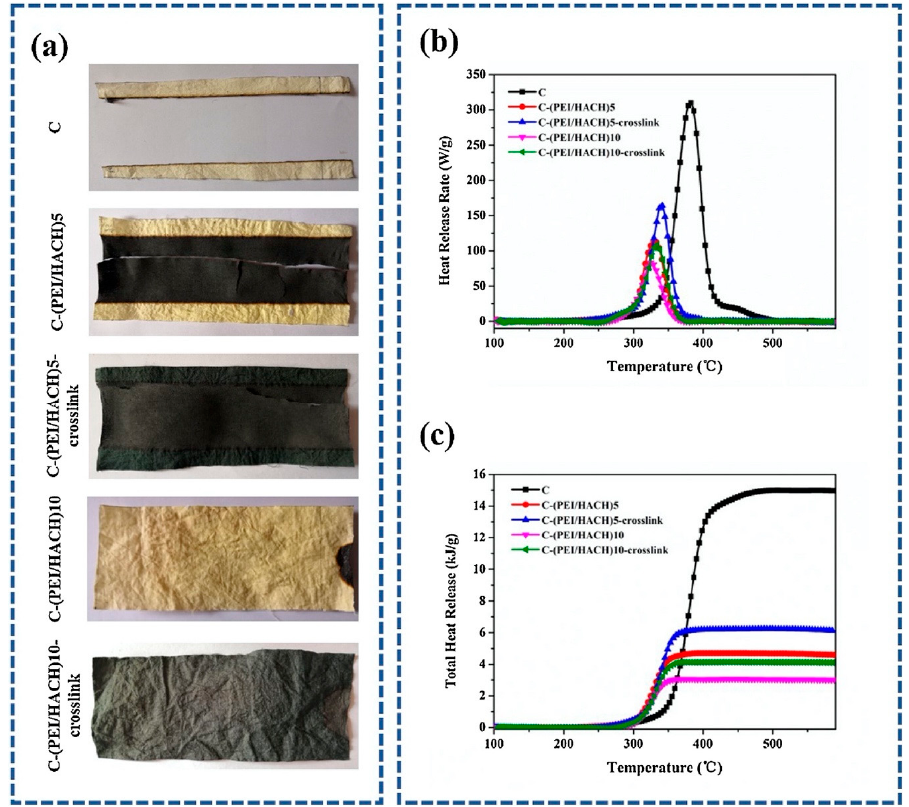
Figure 18. Photographs of untreated and treated cotton fabrics after horizontal burning tests ( a ). Heat Release Rate ( b ) and Total Heat Release ( c ) as a function of temperature for untreated and treated cotton fabrics. C-(PEI/HACH)5: cotton treated with 5 bi-layers of polyethyleneimine; C-(PEI/HACH)5-crosslink: cotton treated with 5 bi-layers of polyethyleneimine and crosslinked with genipin; C-(PEI/HACH)10: cotton treated with 10 bi-layers of polyethyleneimine; C-(PEI/HACH)10-crosslink: cotton treated with 10 bi-layers of polyethyleneimine and crosslinked with genipin. Reprinted with permission from [48]. Copyright 2019, Elsevier.